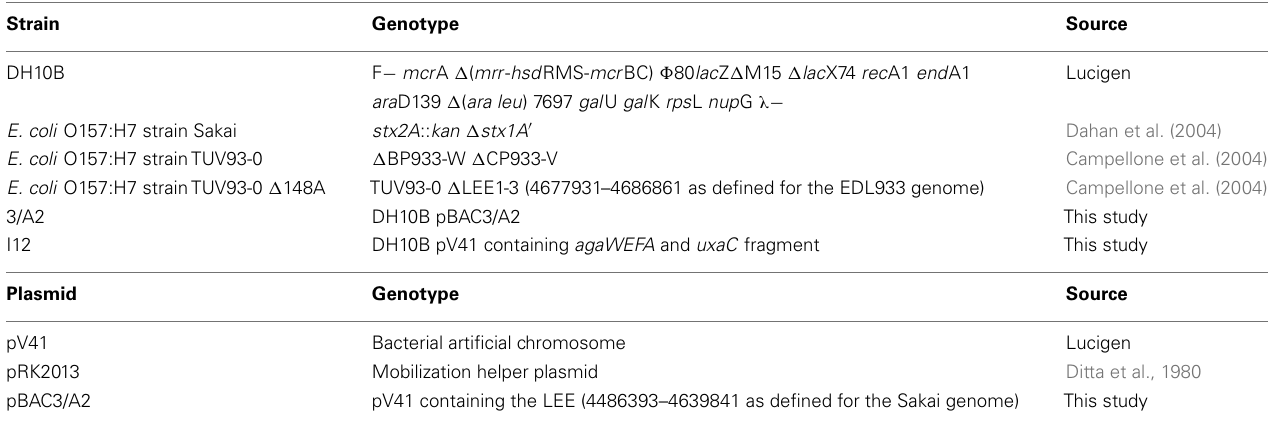
Table 1 | Specific strains and plasmids associated with the